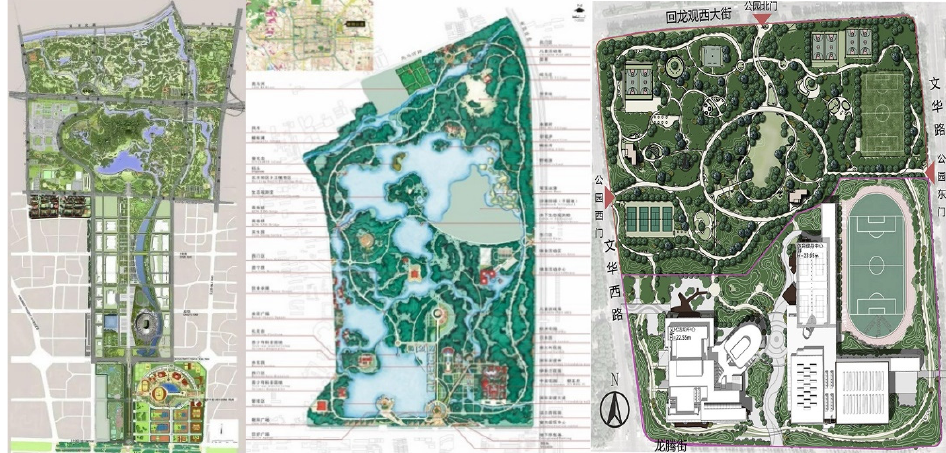
Figure 2. Site plan of the Beijing Olympic Forest Park ( left ), Sun Park ( middle ), and Huilongguan Park ( right ).